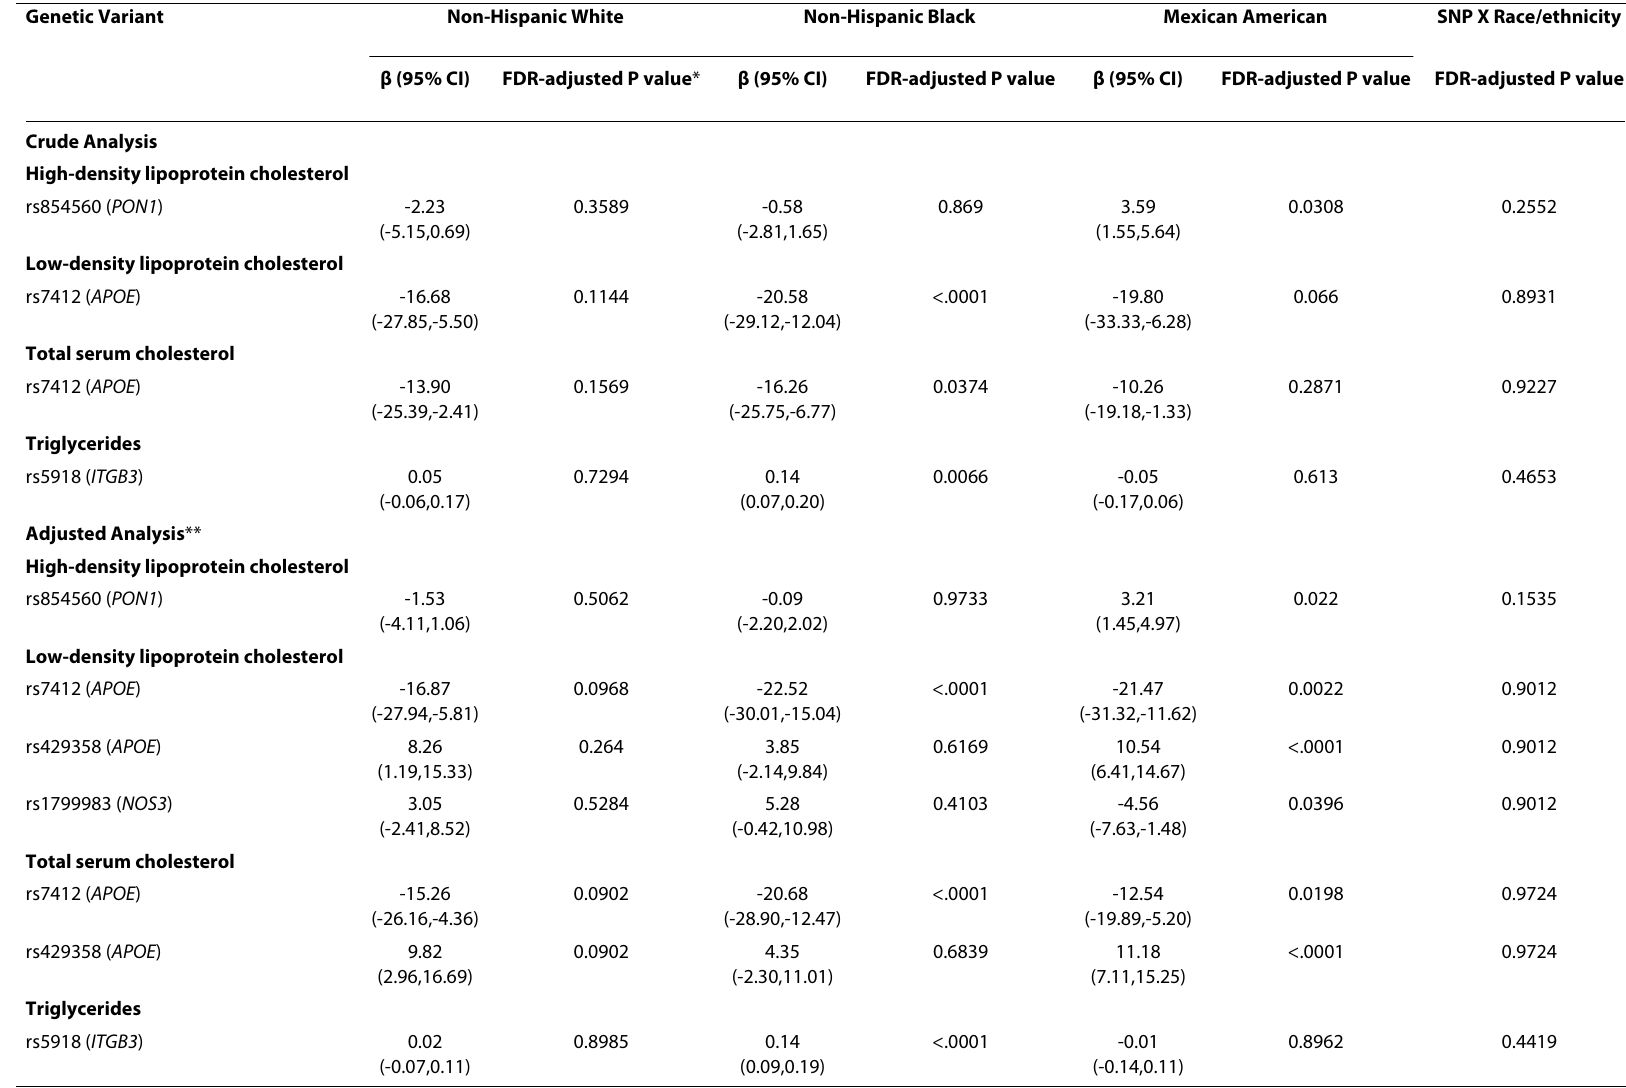
Table 2: Crude and adjusted associations between blood lipids and variants by race/ethnicity - NHANES III (1991-1994) Genetic